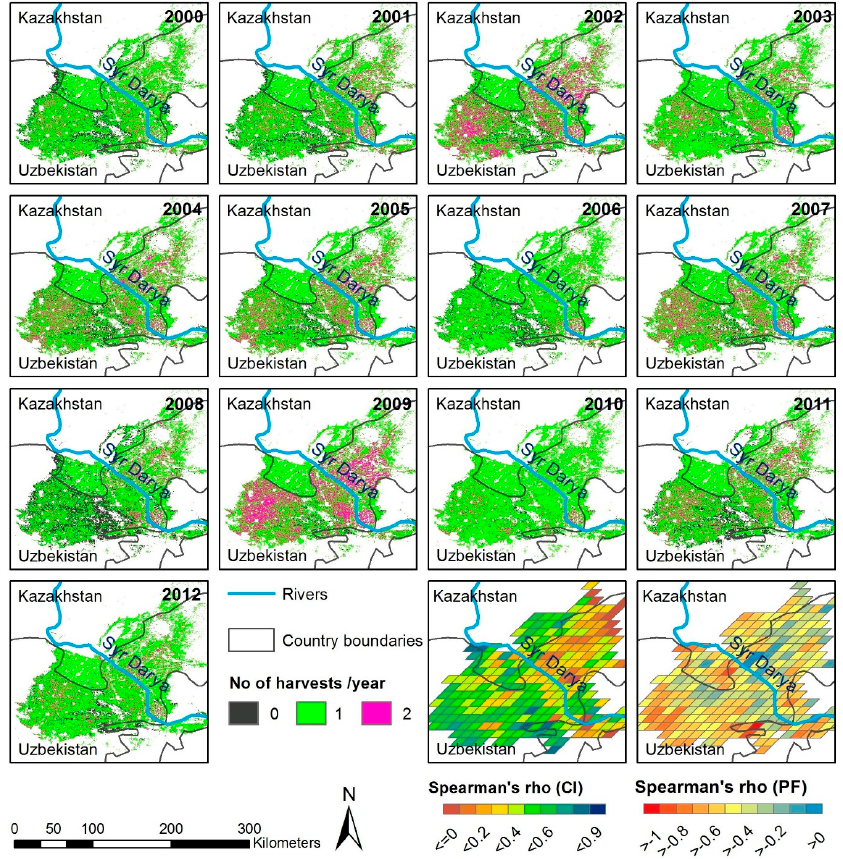
Figure 12. Inter-annual dynamics of cropping intensity in CZ 2 (Tashkent/Syr Darya) 2000–2012, and the respective Spearman’s rho from the correlations between upstream runoff and CI (last line, second map) and PF (last map).